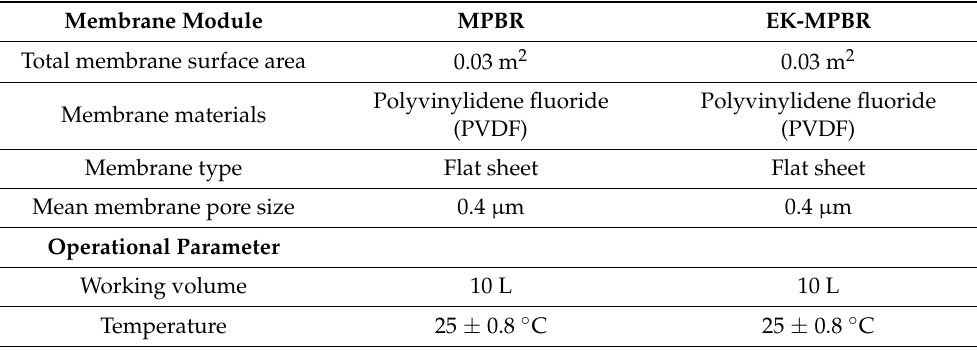
Table 2. Specification of the membrane module and operating